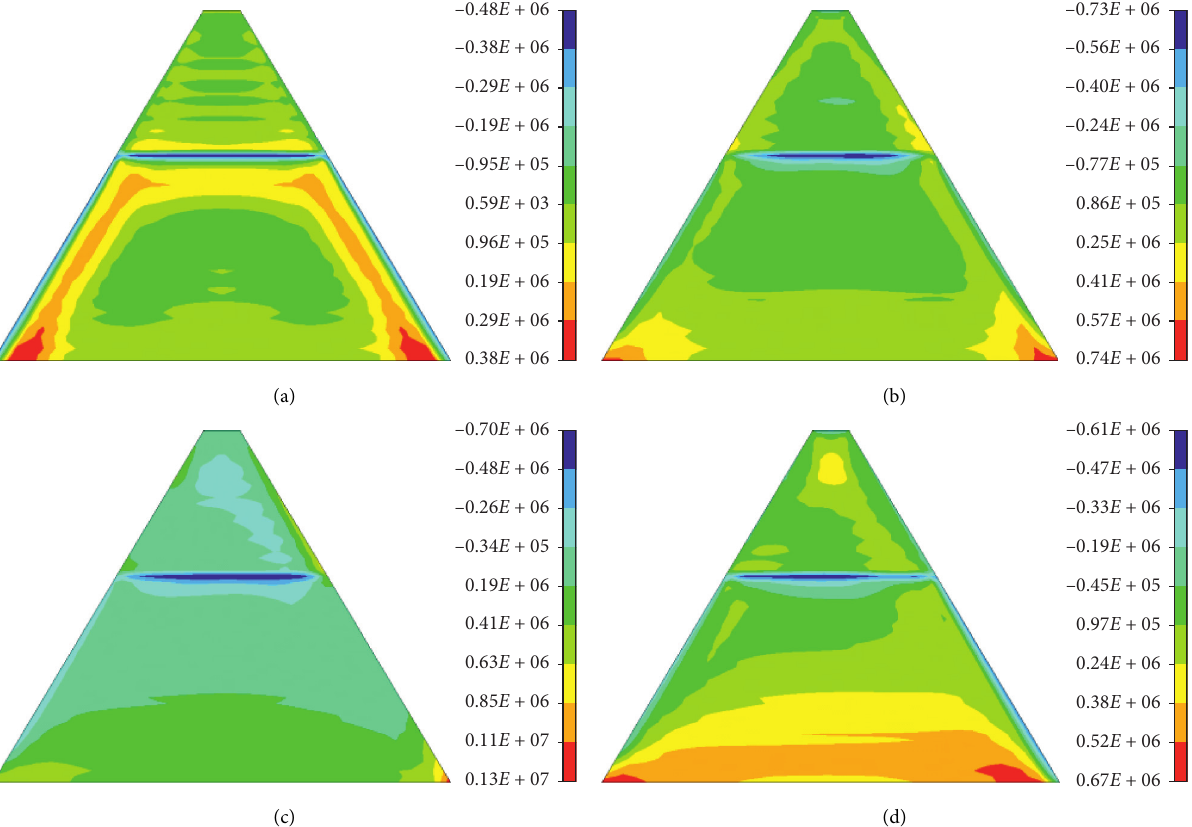
Figure 11: Distribution diagram of temperature stress during construction and operation (unit: Pa). (a) 380d. (b) 1000d. (c) 2000d. (d) 2920d.